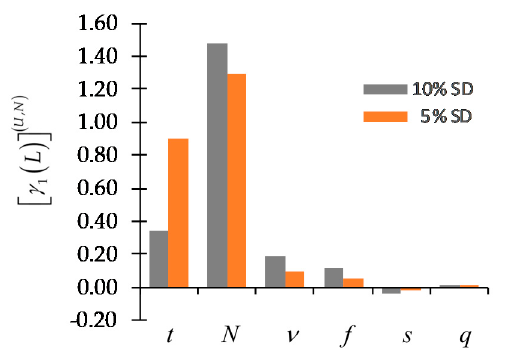
( 2, U , N ) Figure 10. Comparison of [ var ( L )] , i = t , N , ν , f , s , q , due to 5% and 10% standard deviations (SD) of the parameters (considered to be uncorrelated and normally distributed) underlying the total, scattering and fission cross sections, the average number of neutrons per fission, isotopic number densities, and the source parameters, respectively.